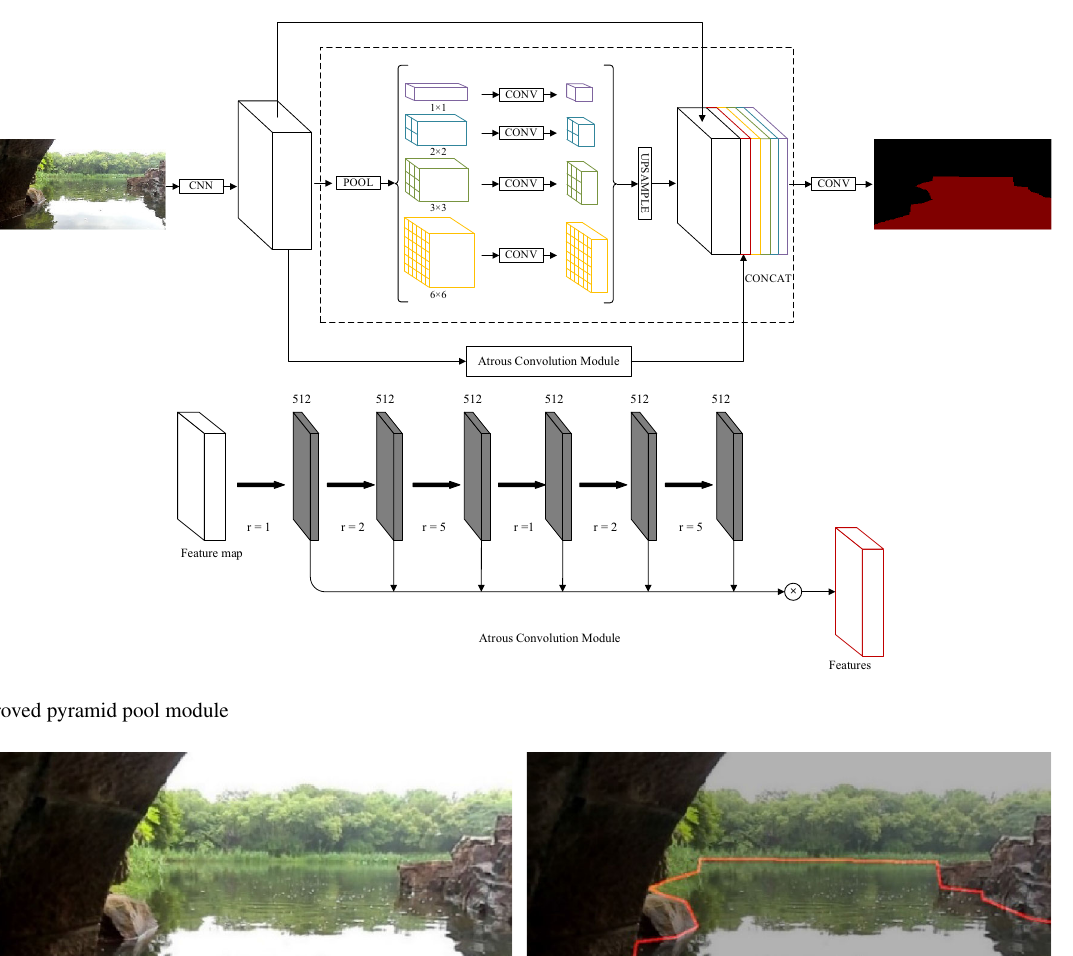
Fig. 9 Display of water shoreline detection results